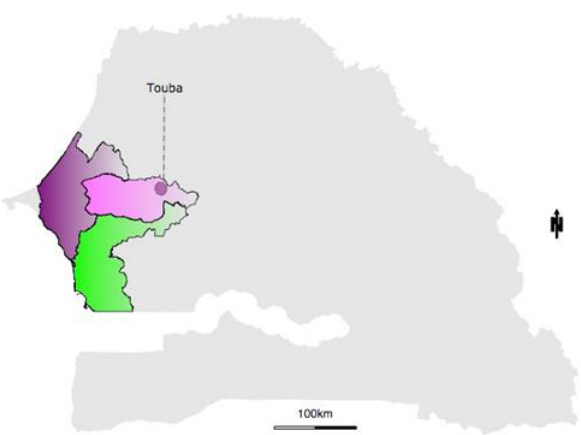
Figure 1. Map showing the Touba (pink) area where the DENV-3 outbreak occurred. In the same period, some sporadic DENV cases were reported in Thiès (Purple) and Fatick (Green).